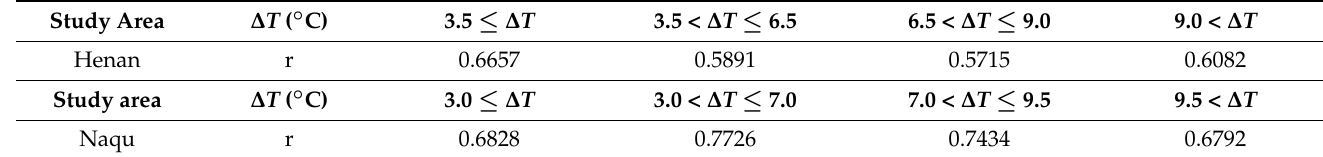
Table 4. The collection between measured and estimated SM in four groups with respect to the ∆ T NDVI values.